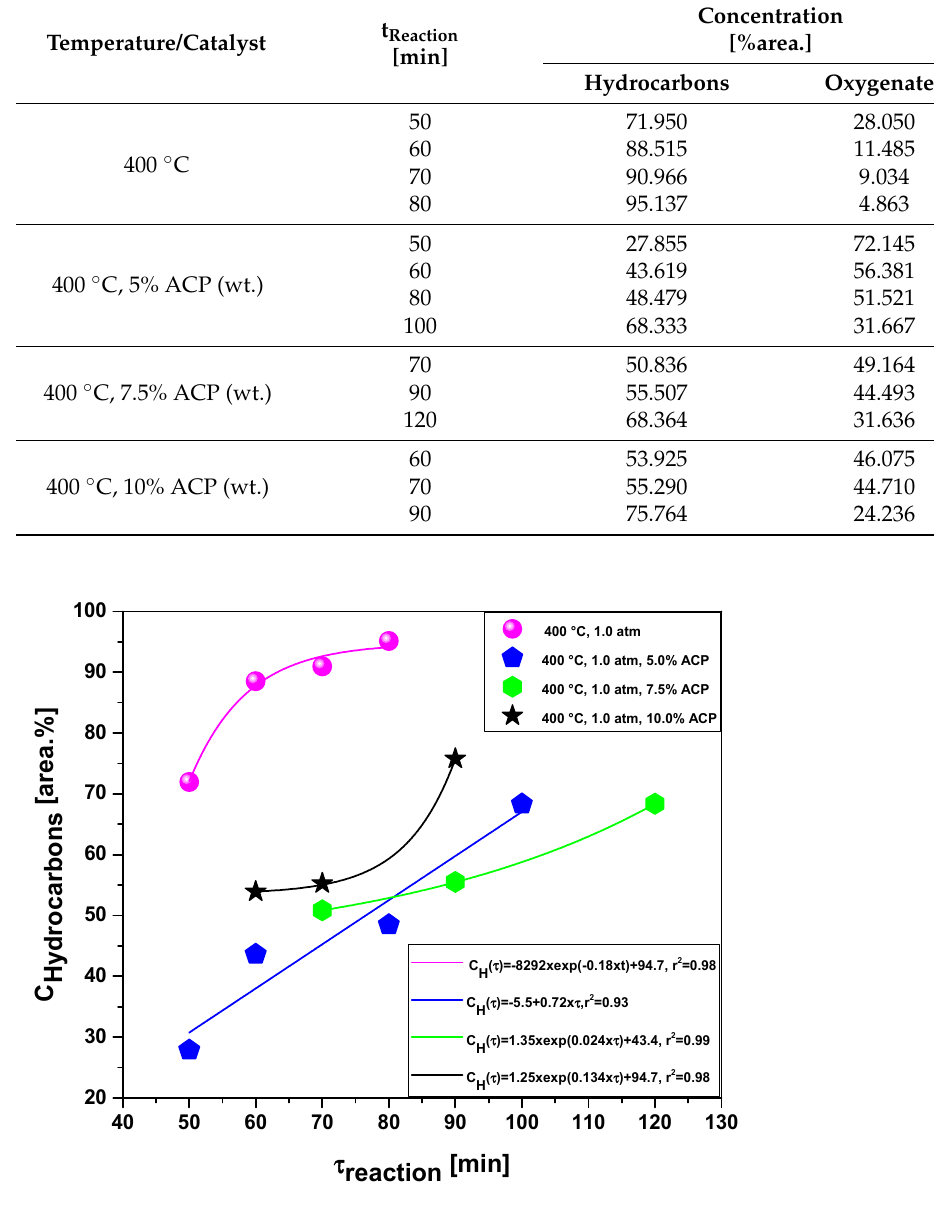
Figure 17. Effect of reaction time on the selectivity of hydrocarbons by the upgrading of residual fat pyrolysis vapors at 400 ◦ C, 1.0 atmosphere, 0.0%, 5.0%, 7.5%, and 10.0% (wt.) activated carbon pellets impregnated with 10.0 M NaOH, using a catalyst fixed-bed reactor, in a semi-pilot scale two-stage reactor of 2.0 L.